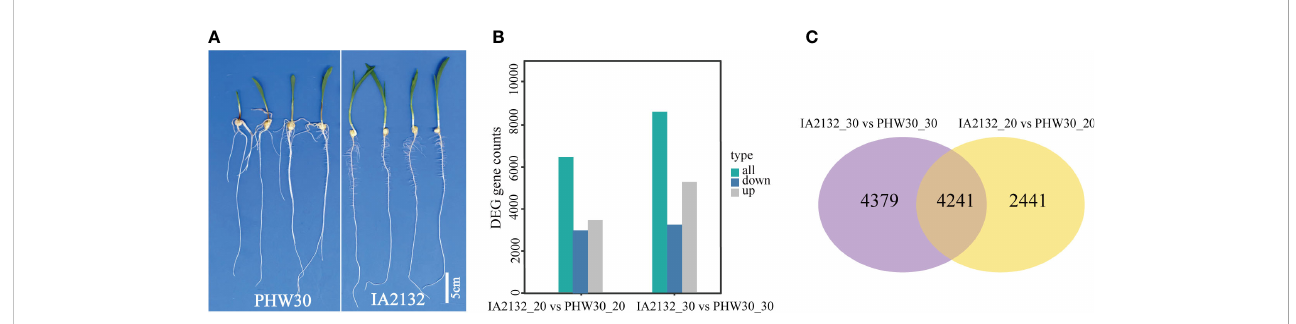
FIGURE 3 Transcriptome sequencing of two inbred lines with extreme difference in SRN. (A) SRN difference between PHW30 and IA2132. (B) DEGs between PHW30 and IA2132 at two sampling times. IA2132_20 vs PHW30_20 and IA2132_30 vs PHW30_30 represent DEGs at 20 th and 30 th days after pollination, respectively. (C) Venn diagram shows overlapping DEGs between IA2132_30 vs PHW30_30 and IA2132_20 vs PHW30_20.